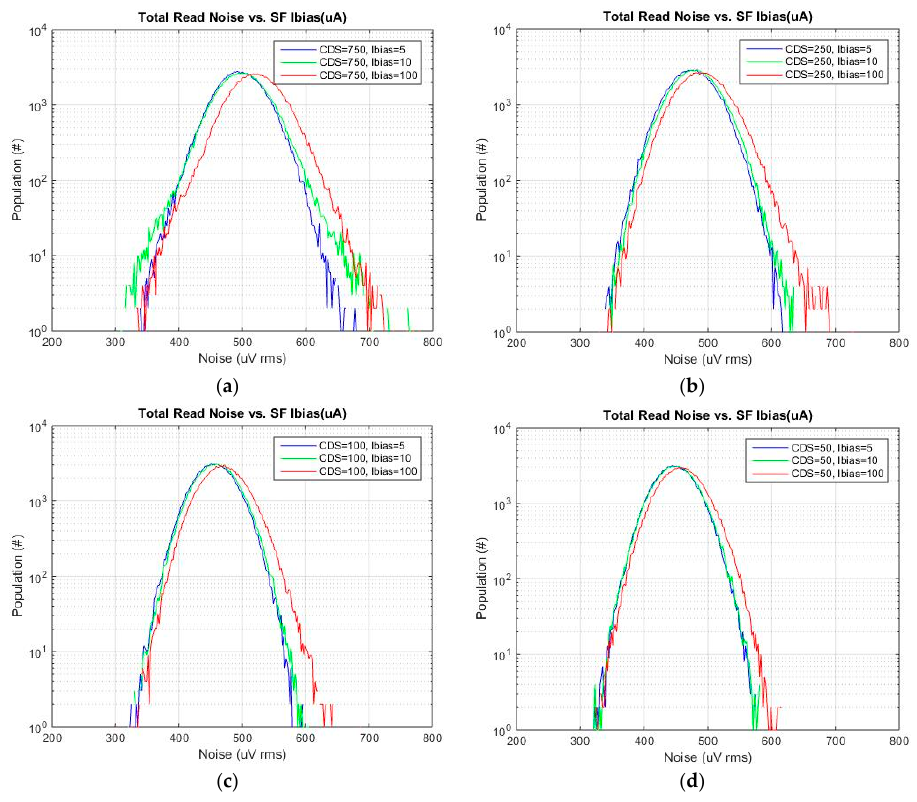
Figure 12. Total read noise histograms for each CDS time vs. SF Ibias. t CDS : ( a ) 750 ns, ( b ) 250 ns, ( c ) 100 ns and ( d ) 50 ns.